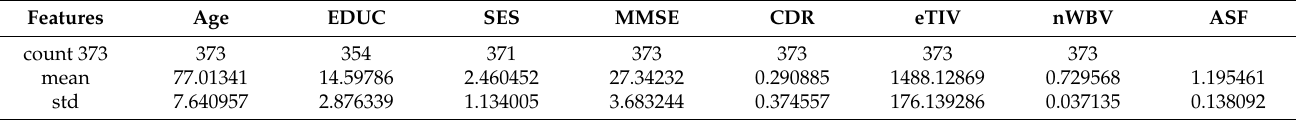
Table 6. Statistical measures of the mean and standard deviation of the OASIS